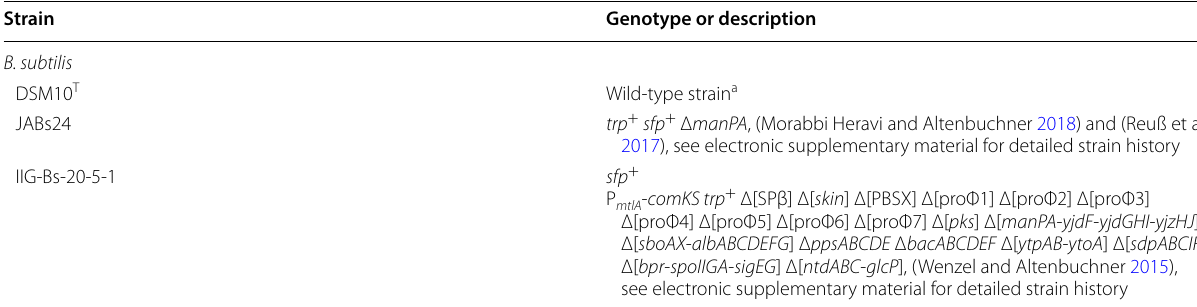
a Deutsche Sammlung von Mikroorganismen und Zellkulturen GmbH (German collection of microorganisms and cell cultures)